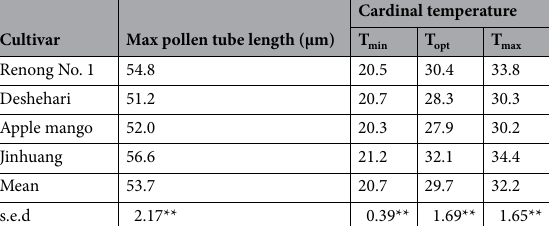
Table 2. Maximum pollen tube length and cardinal temperatures for pollen tube length of four mango genotypes in response under different temperature stress. *P < 0.05, **P < 0.01.